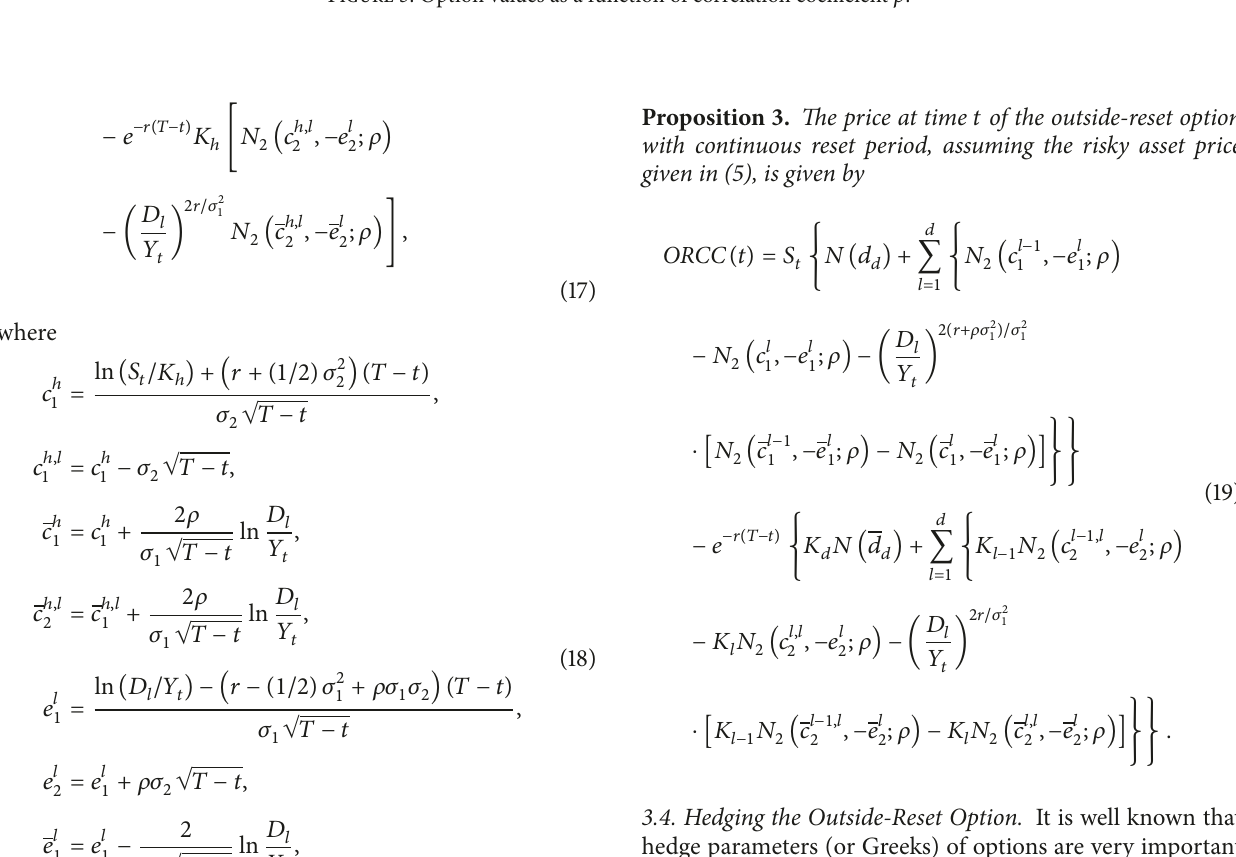
Figure 3: Option values as a function of correlation coefficient 𝜌